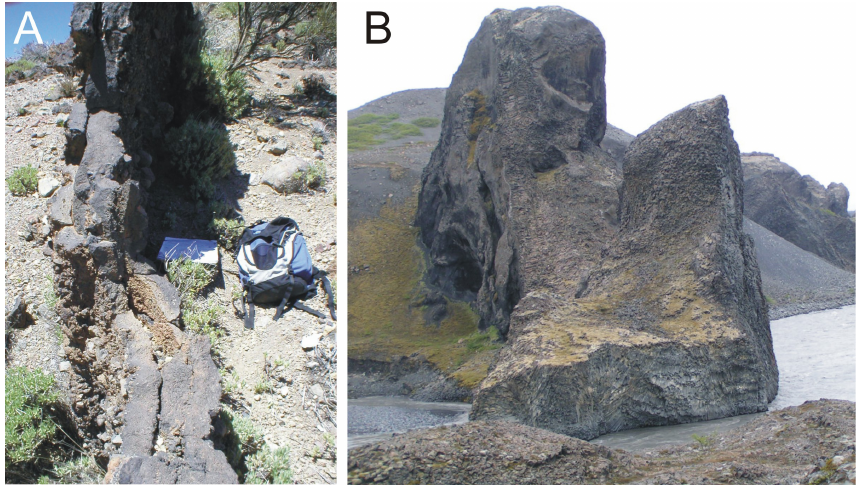
Fig. 8. Segmented feeder dykes. (A) The Colmenas feeder dyke (Tenerife) is composed of several segments some of which have coalesced through narrow channels. The segment main trend changes when approaching the nearby segment. (B) The Hljodaklettar feeder dyke (Ice- land) is much thicker (approximately 25m) than the Colmenas dyke and the segments are